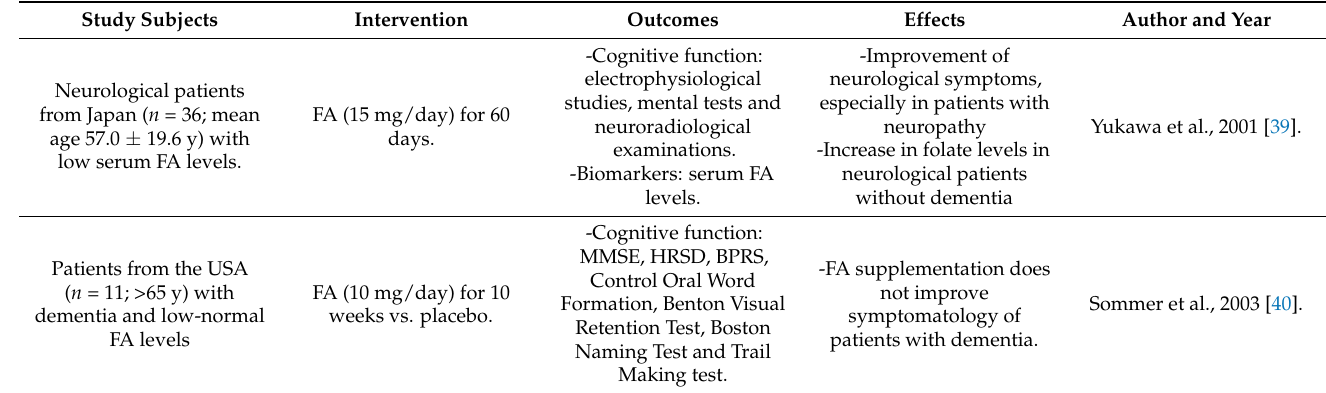
Table 1. Summary of the interventions based on folic